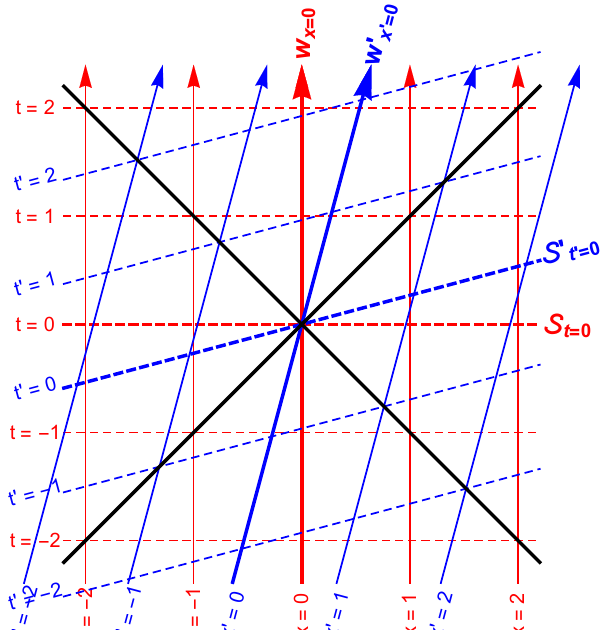
Figure 1. Minkowski spacetime M as charted in time coordinate t and position space coordinate x (other position space dimensions suppressed) by a global inertial frame (cid:79) (red), in units with c = 1. A second inertial frame (cid:79) (cid:48) (blue) with coordinates t (cid:48) , x (cid:48) moving with positive velocity in the x direction relative to (cid:79) is also shown, as are the past and future null cones (black) emanating from the common origin of (cid:79) and (cid:79) (cid:48) . Curves of constant x , y , z and x (cid:48) , y (cid:48) , z (cid:48) can be regarded as the worldlines of families of inertial observers (solid lines with arrows; those passing through the origin are labeled and distinguished with heavier line weight), whose four-velocities are given by timelike tangent vectors w and w (cid:48) to the t and t (cid:48) coordinate curves. Hyperplanes of simultaneity S and S (cid:48) of (cid:79) and (cid:79) (cid:48) (dashed lines; those passing through the origin are labeled and distinguished with heavier line weight) are defined by constant values of t and t (cid:48) , respectively, and are submanifolds with Euclid geometry charted by the position space